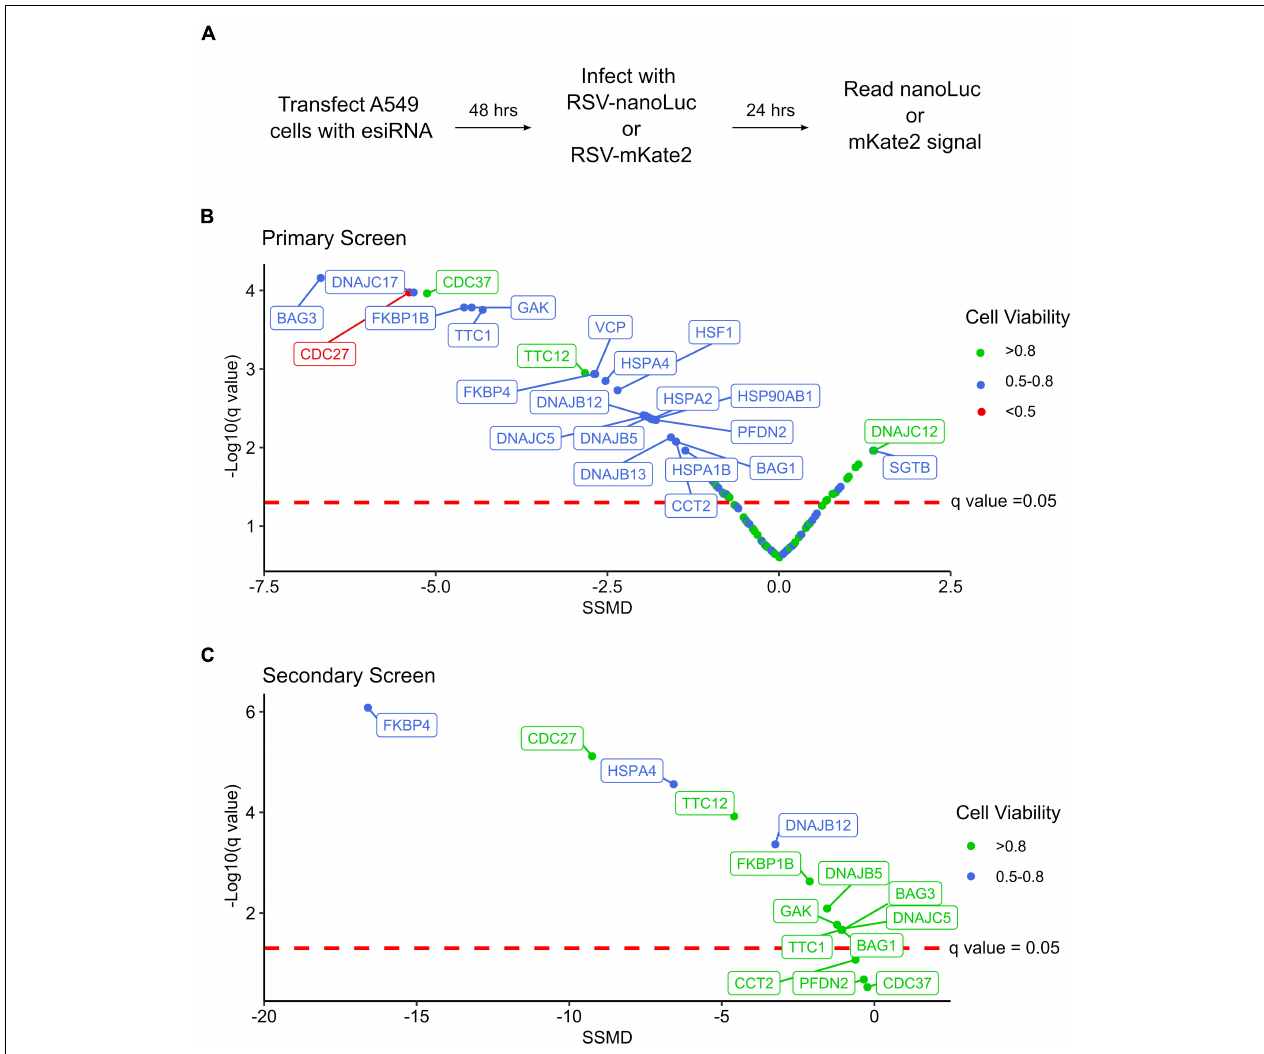
FIGURE 1 | An RNAi screen for chaperones and co-chaperones involved in RSV replication. (A) Overview of the experimental approach. (B) Results of the primary screening, showing the strictly standardized mean deviation (SSMD) and the statistical significance ( q -value). n = 6. (C) Results of the secondary screening, showing the SSMD and statistical significance. n =